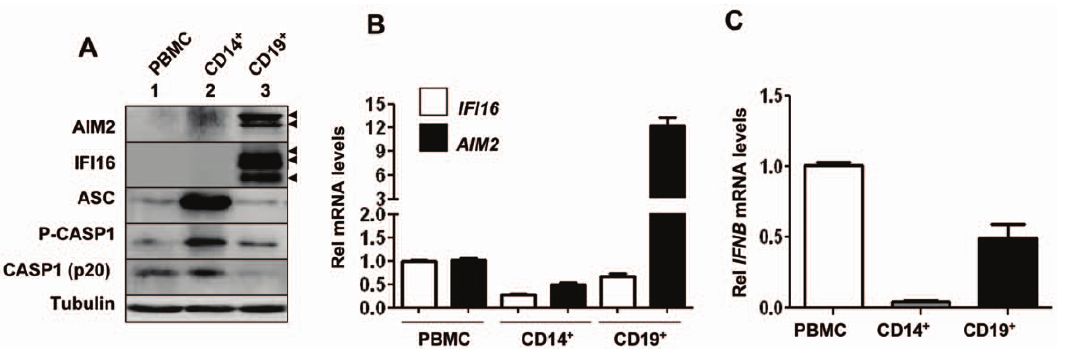
Figure 1. Expression of the IFI16 and AIM2 proteins is cell type dependent. ( A ) Total cell extracts containing equal amounts of proteins from peripheral blood mononuclear cells (PBMNC), purified monocytes (CD14 + ), or B lymphocytes (CD19 + ) were analyzed by immunoblotting using antibodies specific to the indicated proteins. The arrowheads indicate different forms of the AIM2 (53 and 49 kDa) and IFI16 (A, B, and C forms) proteins. ( B ) Total RNA was extracted from total PBMNCs, purified CD14 + or CD19 + cells. Steady state levels of the IFI16 or AIM2 mRNA were analyzed by quantitative TaqMan real-time PCR. The ratio of the test gene to actin mRNA was calculated in units (one unit being the ratio of the test gene to actin mRNA). Results are mean values of triplicate experiments and error bars represent standard deviation. ( C ) Total RNA as described in panel ( B ) was also analyzed by the quantitative TaqMan real-time PCR for the IFN- b mRNA. Again, the ratio of the test gene to actin mRNA was calculated in units. Results are mean values of triplicate experiments and error bars represent standard